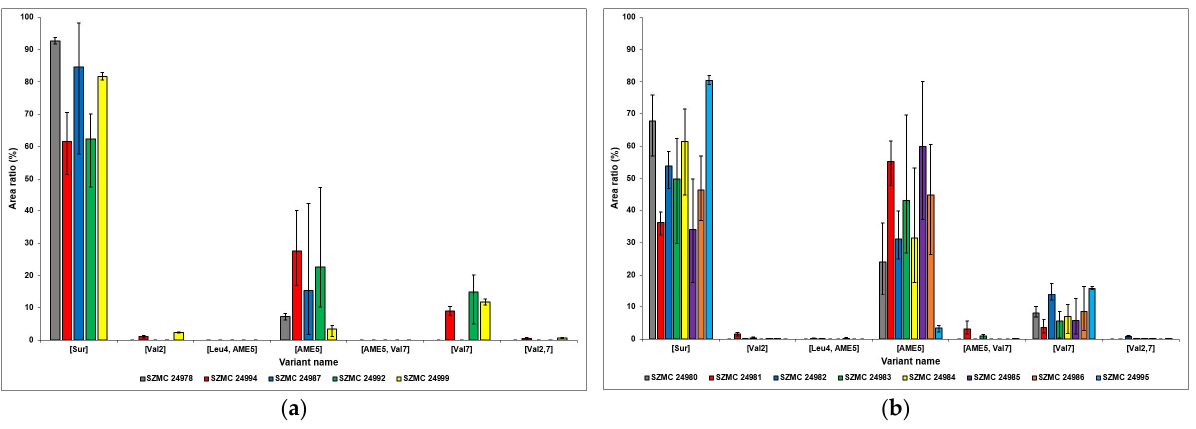
Figure 5. The ratios of all surfactin isoforms produced ( a ) by B. atrophaeus (SZMC 24978), B. cereus (SZMC 24994), B. pumilus (SZMC 24987 ) , and B. subtilis (SZMC 24992, SZMC 24999) as well as ( b ) by B. velezensis (SZMC 24980, SZMC 24981, SZMC 24982, SZMC 24983, SZMC 24984, SZMC 24985, SZMC 24986, SZMC 24995) strains.